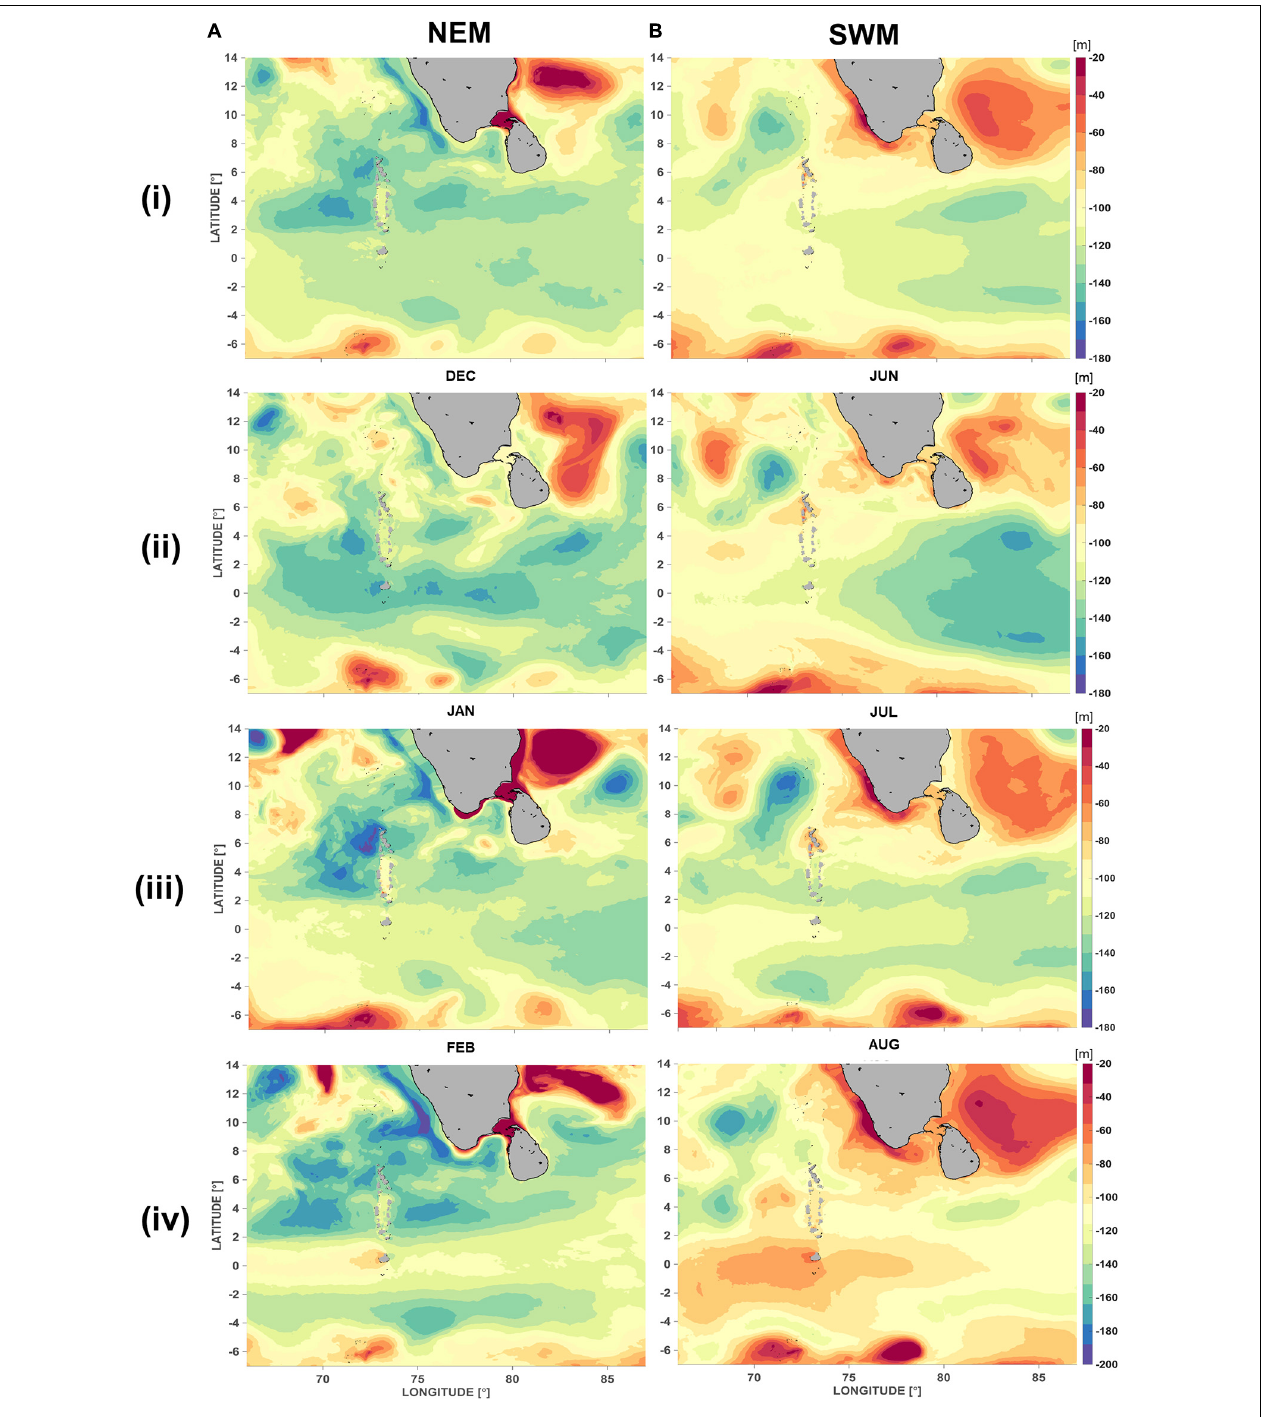
FIGURE 9 | Mapped depths of the 26 ◦ C isotherm (D26) relative to the mean during the (A) NEM (i) December (ii) January (iii) February and (B) SWM—(i) June (ii) July (iii) August. Shallower (deeper) values where the colormap is warmer (cooler) identify locations where the 26 ◦ C isotherm (D26) is uplifted (suppressed).